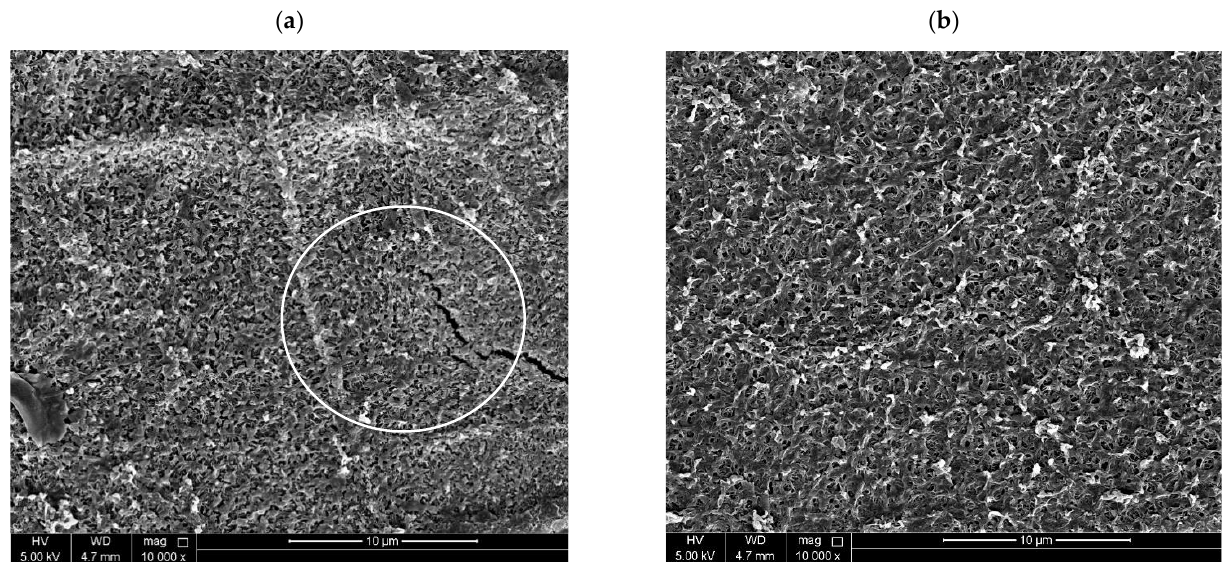
Figure 12. ( a ) Impact of chlorination conditions on the water flux of the TFC and TFNC membranes treated with a 1000 ppm NaOCl solution for 2 – 6 h at pH 5.5; ( b ) effect of chlorination conditions on the SRSF of TFC and the B-GQD TFNC membranes treated with a 1000 ppm NaOCl solution for 2 – 6 h at pH 5.5.